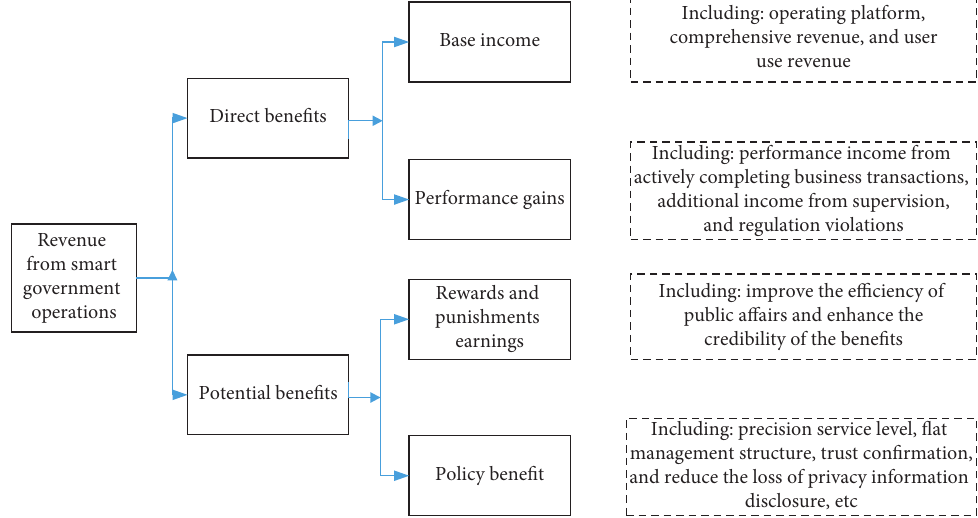
Figure 5: Analysis of the operational income of smart government projects based on blockchain technology.